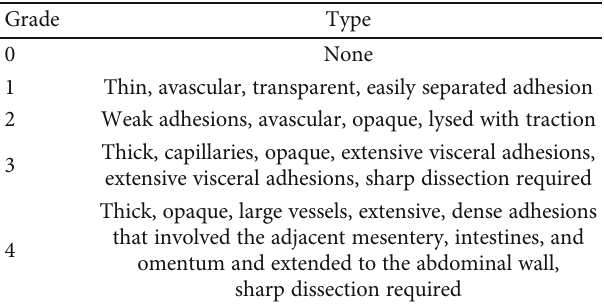
Table 2: Classi fi cation for extent and severity of intraperitoneal